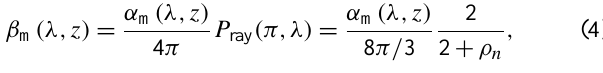
Figure 3. Corrected (thin red) and uncorrected (thin black) count rates (MHz) from a sample 20min profile from the elastic channel Fig.3. Corrected(thinred)anduncorrected(thinblack)countrates( MHz )fromasample20minprofile are shown. The difference (%) between these and the true count rate from the elastic channel are shown. The difference ( % ) between these and the true count rate (glued, thin blue) is given by the red and black dot-dashed lines respectively. (glued, thin blue) is given by the red and black dot-dashed lines,